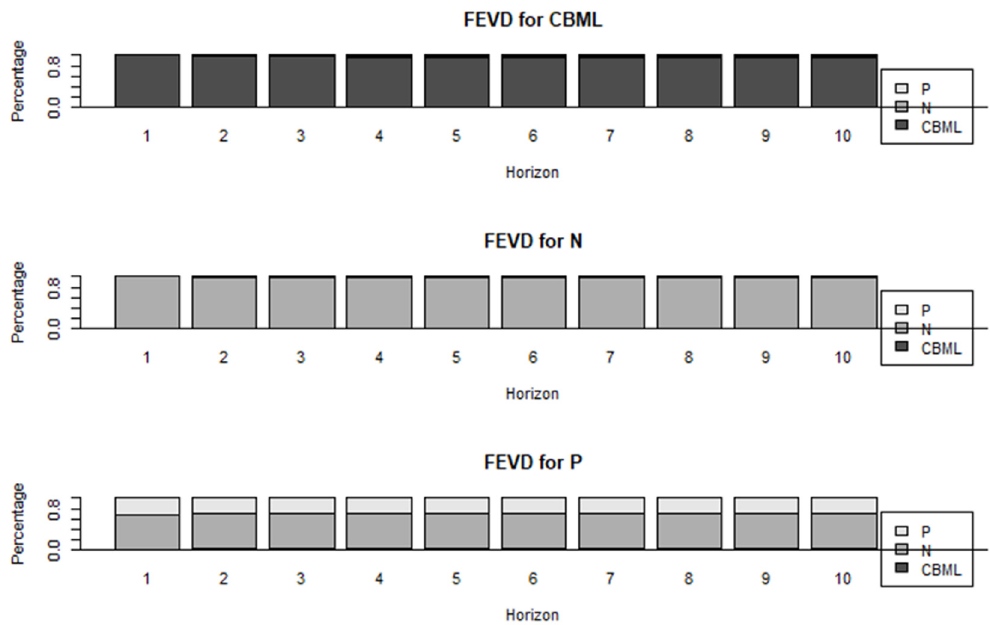
Figure 3. FEVD analysis for CBML and investor sentiments.